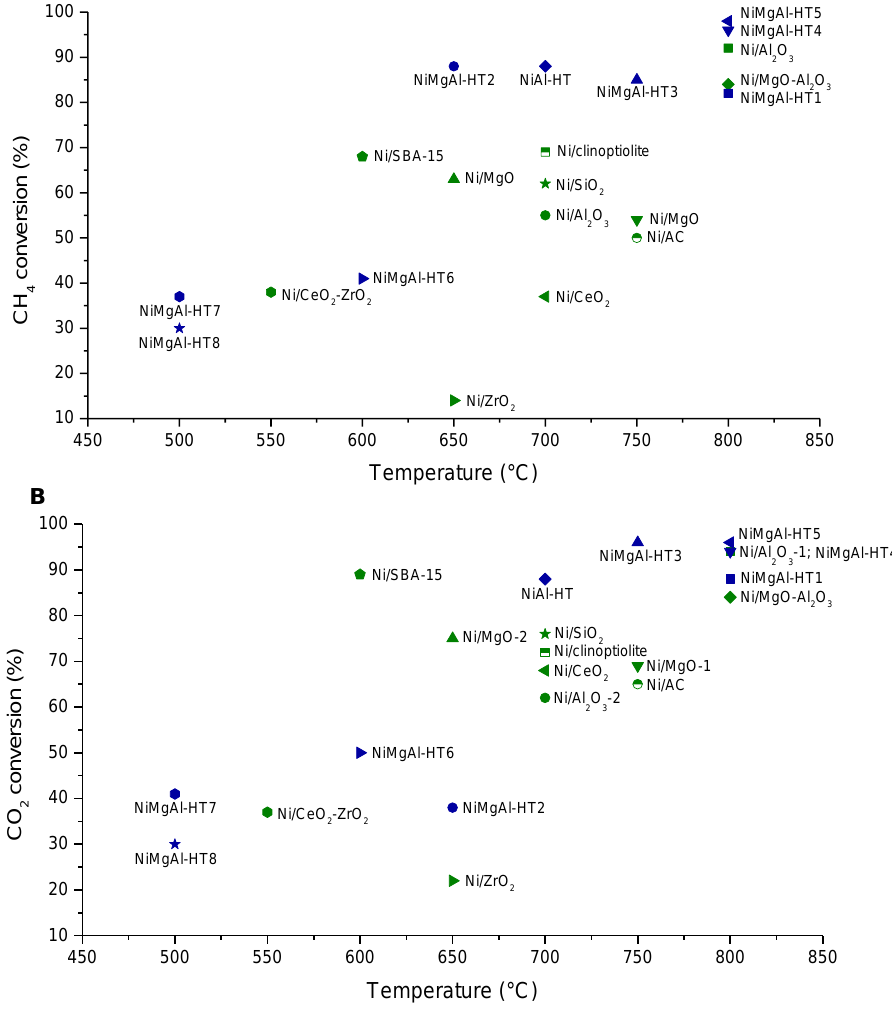
Figure 4. Catalytic activity of nickel-based catalysts in dry reforming of methane: ( A ) CH 4 conversions and ( B ) CO 2 conversions, as a function of temperature; Green symbols—catalysts Ni/support: Ni/Al 2 O 3 -1 [23], Ni/Al 2 O 3 -2 [24], Ni/MgO-1 [25], Ni/MgO-2 [26], Ni/MgO-Al 2 O 3 [33], Ni/CeO 2 [27], Ni/ZrO 2 [28], Ni/CeO 2 -ZrO 2 [36], Ni/SiO 2 [20,29], Ni/SBA-15 [30], Ni/clinoptilolite [39], Ni/AC [43]; Blue symbols—hydrotalcite-derived catalysts: NiMgAl-HT1 [53], NiMgAl-HT2 [54], NiMgAl-HT3 [55]; NiMgAl-HT4 [56]; NiMgAl-HT5 [57], NiMgAl-HT6 [58], NiMgAl-HT7 [59], NiMgAl-HT8 [60], NiAl-HT [61].